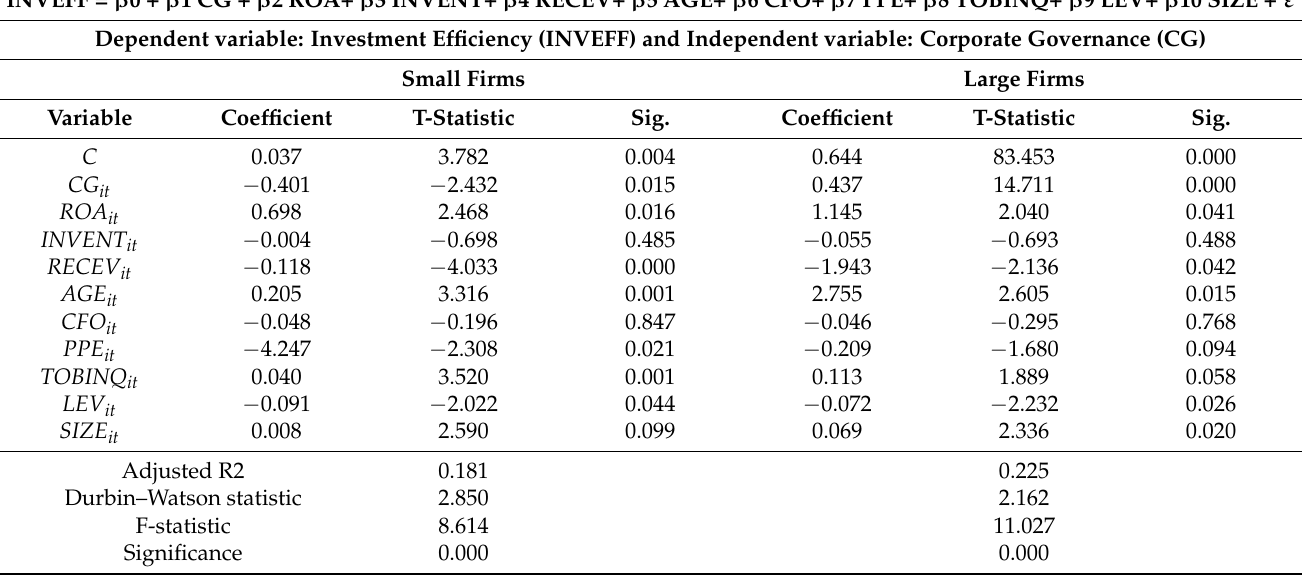
Table 14. The results of the statistical test for the first hypothesis in small and large firms.